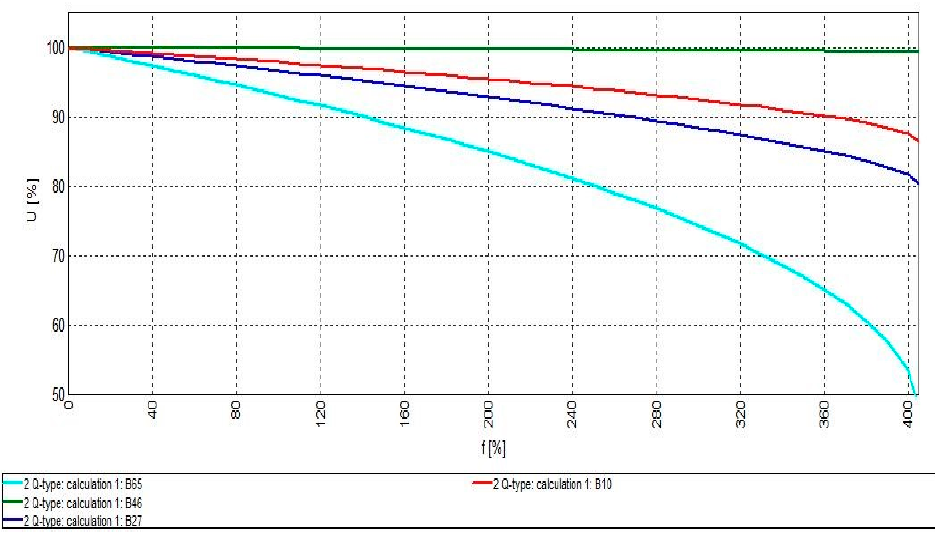
Figure 9. PV curves of the IEEE 69 ‐ node RDS system with 3 Q ‐ type DG installations. Again, Figure 9 shows that there is almost no drastic effect on the system’s PV curves when installing 3 Q ‐ type DGs. The voltage of node 65—the system’s weakest node in that case—starts to fall below 90% of nominal voltage when loads exceed 140%, and the system collapses when loads exceed 400%. 4.3. System Optimization with Active and Reactive Power ‐ Generating DG (PQ ‐ Type Mode): In this case, the DGs installed are PQ ‐ type DGs and are configured for system opti ‐ mization regarding the objective function as it is shown in Table 3.